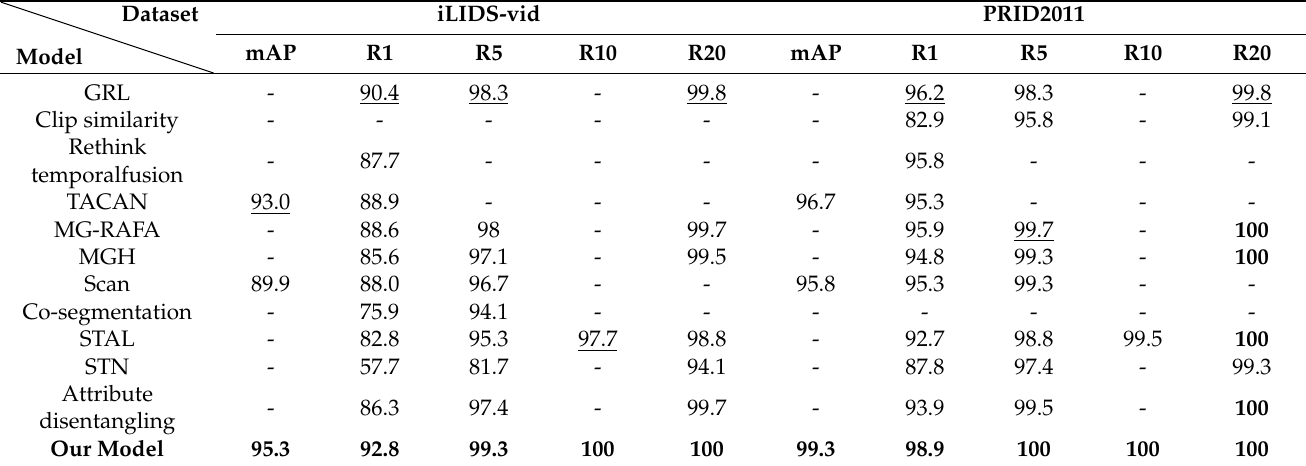
Table 3. Comparing the Models’ Performance Using Small-Scale Datasets.